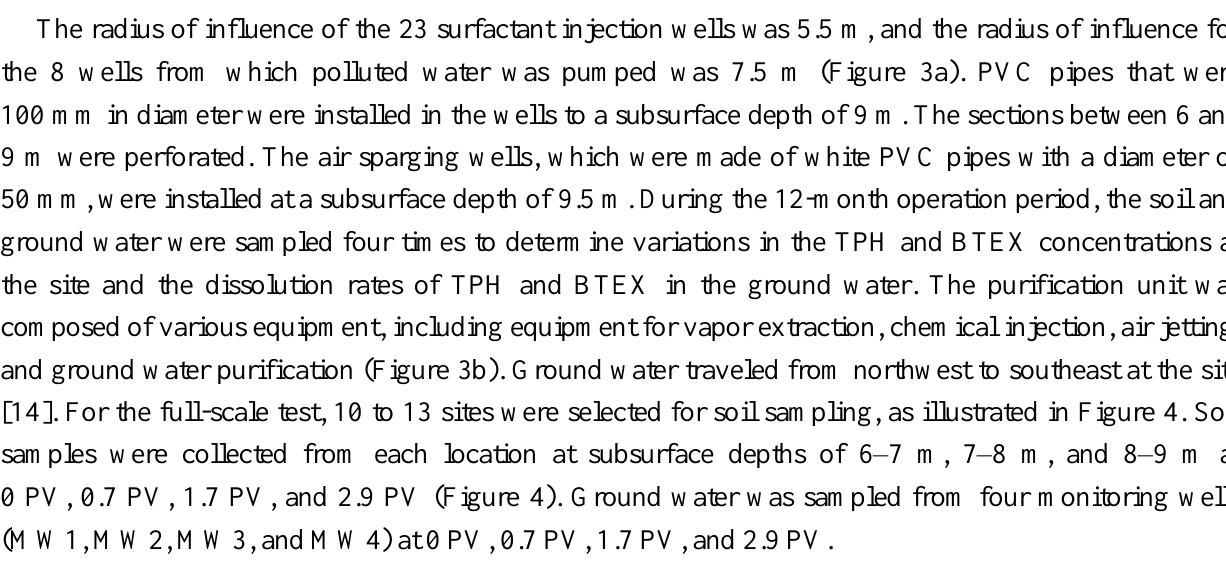
Figure 4. Soil sampling locations for the full-scale study at ( a ) 0, ( b ) 0.7, ( c ) 1.7, and ( d ) 2.9